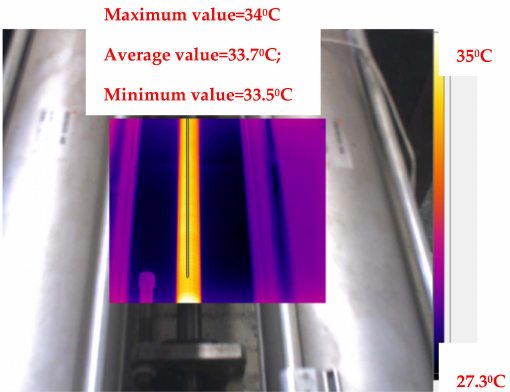
Figure 9. Experimental results: steady-state field of the ball